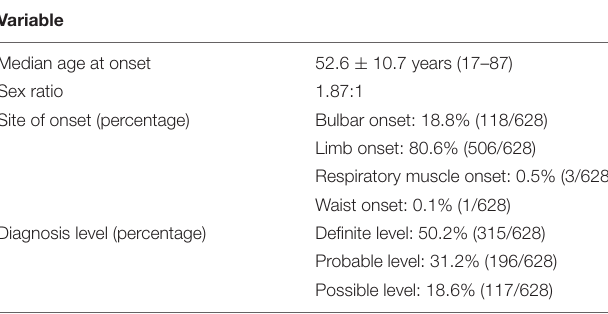
TABLE 1 | Demographic characteristics of ALS